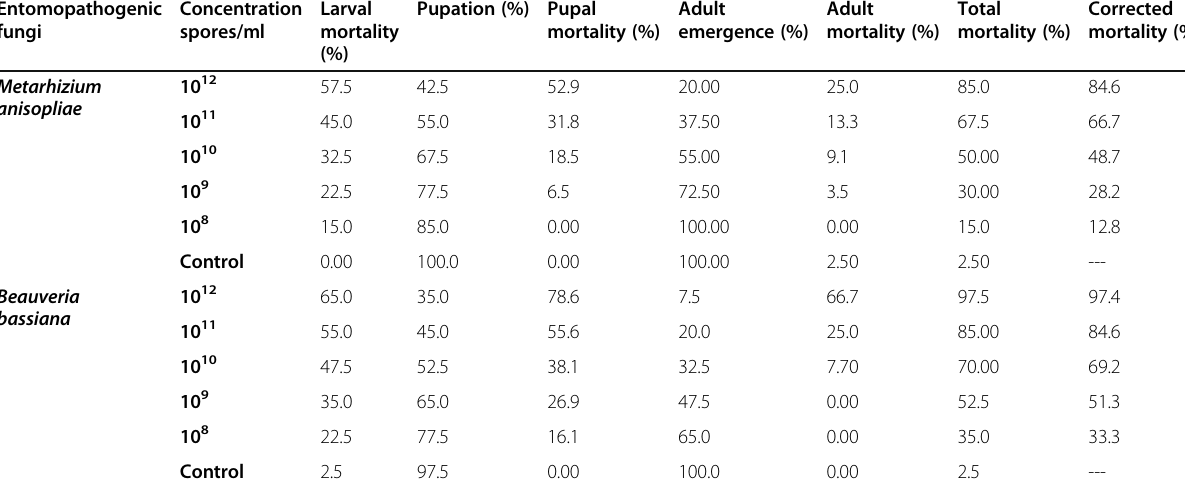
Table 3 Effect of the fungal isolates against the early 4 th instar Pectinophora gossypiella larvae Entomopathogenic Concentration fungi